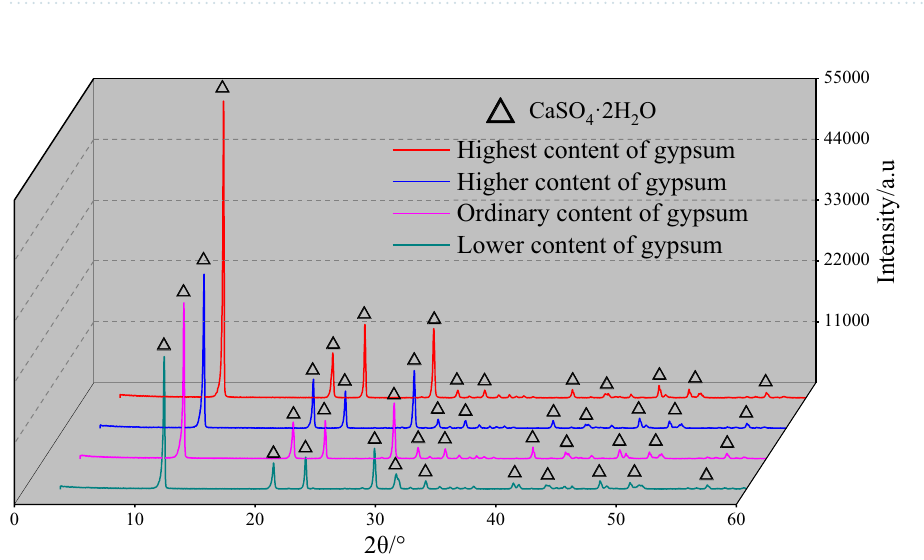
Figure 3. X-ray diffraction curves of the four kinds of gypsum rocks. (The Figure is just obtained from the process of XRD test data by the data mapping software of Origin 2018, https:// www. origi nlab. com/ index. aspx.)